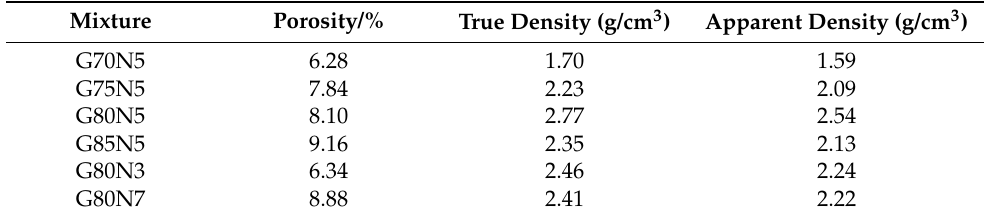
Table 4. Physical properties of test